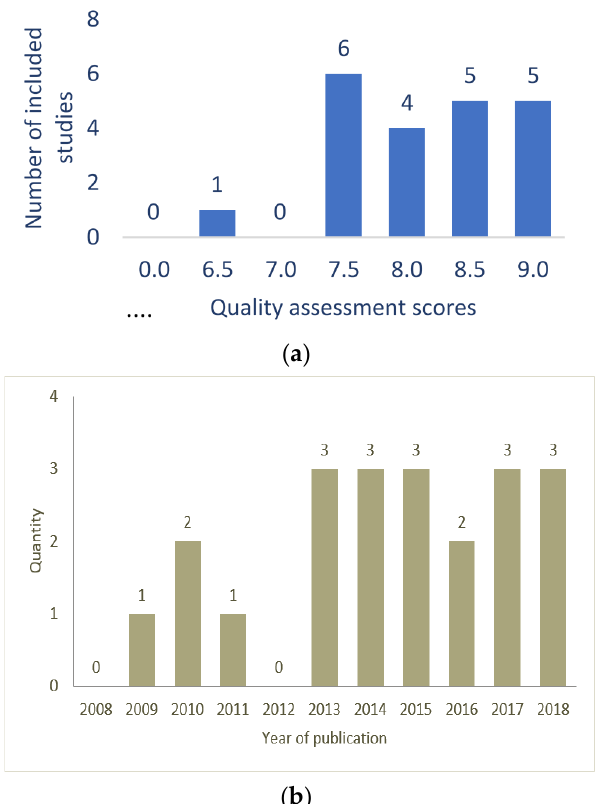
Figure 2. ( a ) Quality assessment of the 21 included studies. ( b ) Publication year distribution.